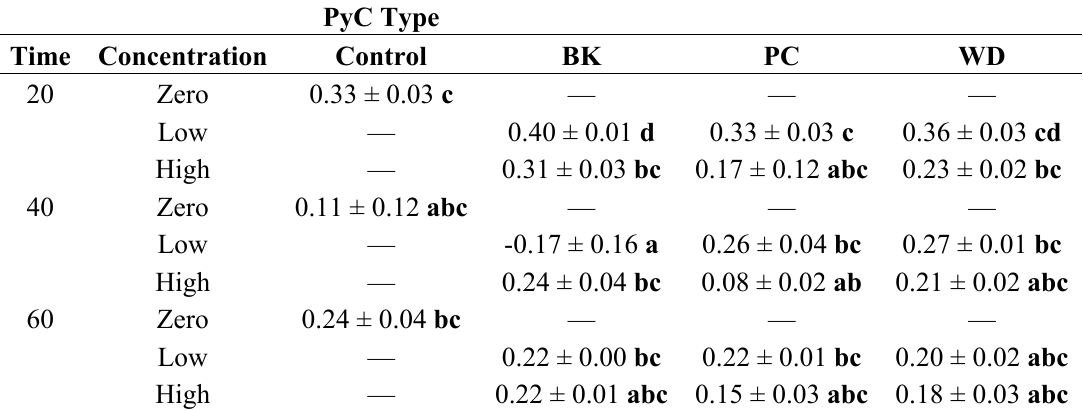
Figure 4. ( A ) Ammonification rate, ( B ) nitrification rate, and ( C ) total N mineralization rate of soils incubated with charred bark (yellow), charred pine cones (blue), or charred woody debris (green) at either zero (black, control), low (0.1%), or high (1.0%) PyC concentrations. The soils were incubated for 20, 40, 60 days (T 20 , T 40 , T 60 , respectively). The error bars represent one standard error. Table 3. Summary table of means ± standard errors (one standard error) for N mineralization rates ( μ g N g Soil − 1 day − 1 ) of soils incubated for 20, 40, and 60 days with charred bark (BK), charred pine cones (PC), or charred woody debris (WD) at zero (control), low (0.1%), or high (1.0%) PyC